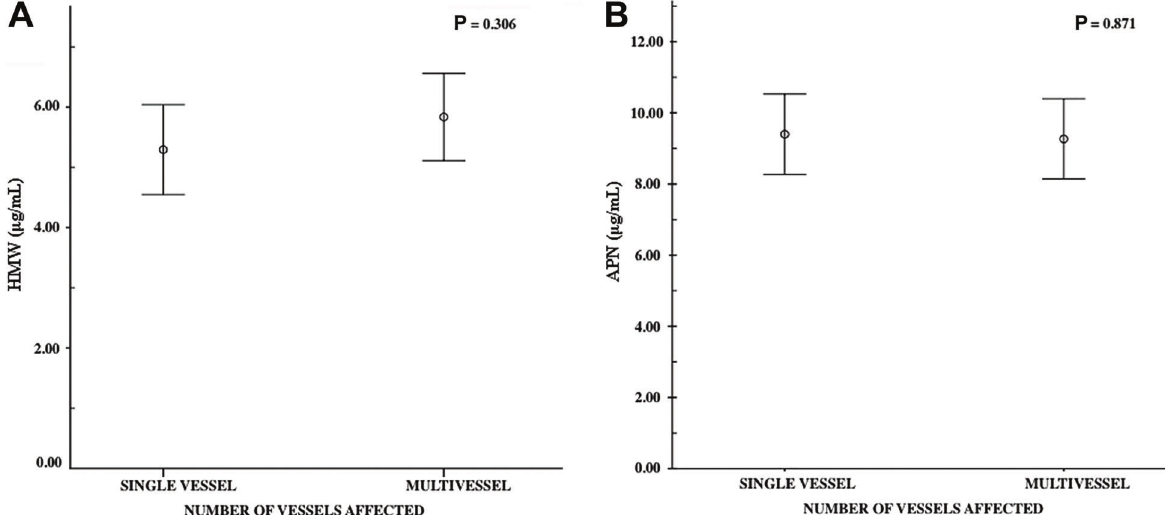
Figure 1. Association of high molecular weight (HMW) adiponectin (APN) ( A ) and APN ( B ) levels with number of affected coronary vessels. Data are reported as means ± SD (Mann-Whitney U test)